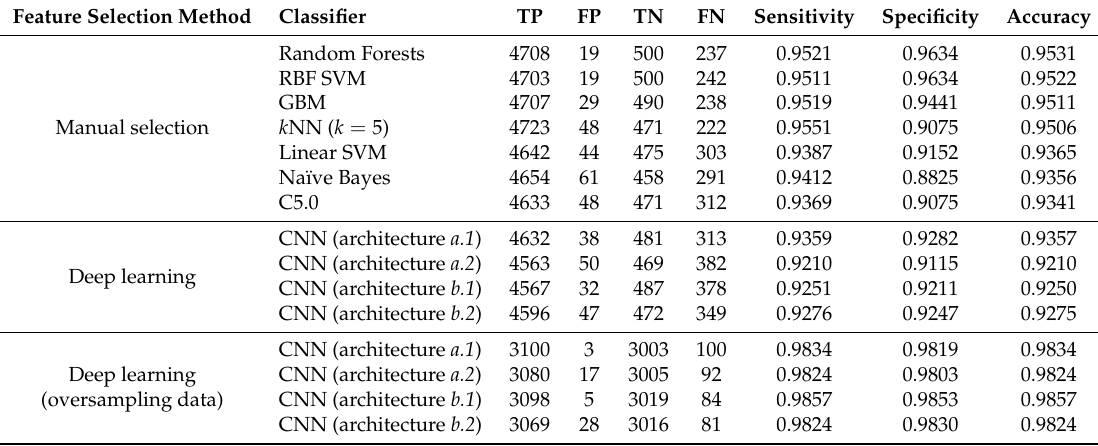
Table 3. Summary of results using the feature-based proposal with different